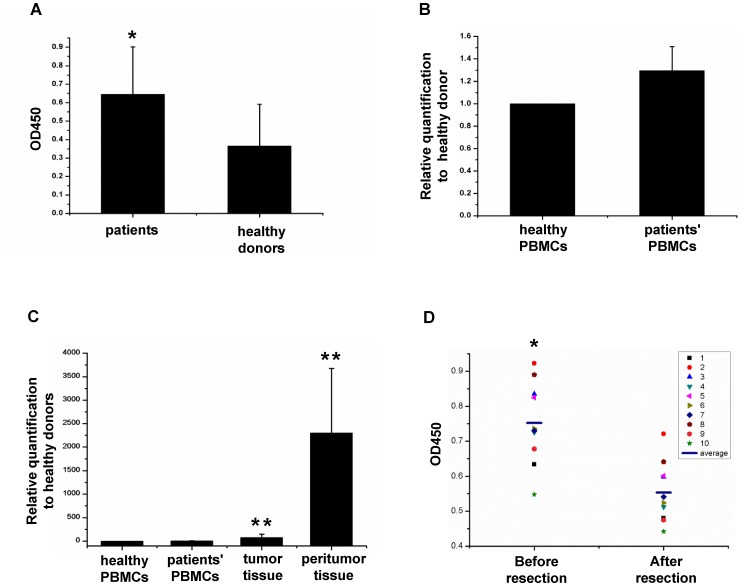
Comparison in the expression of spliced sB7-H3 between patients and healthy donors.A, Sera were obtained from healthy donors or patients with HCC. The expression level of spliced sB7-H3 was monitored with sandwich ELISA assay. B, The cDNAs produced from PBMCs of healthy donors or patients with HCC were analyzed for expression of spliced sB7-H3 by real-time PCR assay. A greater than 2-fold increase over health donors was considered clinical significant. C, The expression of spliced sB7-H3 in PBMCs of healthy donors and patients, as well as patients' tumor tissues and peritumor tissues were evaluated with comparative qPCR assay. A greater than 2-fold increase in value over healthy donors was considered clinical significant. D, Spliced sB7-H3 of individual serum from patients enrolled with HCC before and after resection was evaluated with sandwich ELISA assay. The horizontal line indicates the mean value of each group. “*” indicated P<0.05, “**” indicated P<0.01.